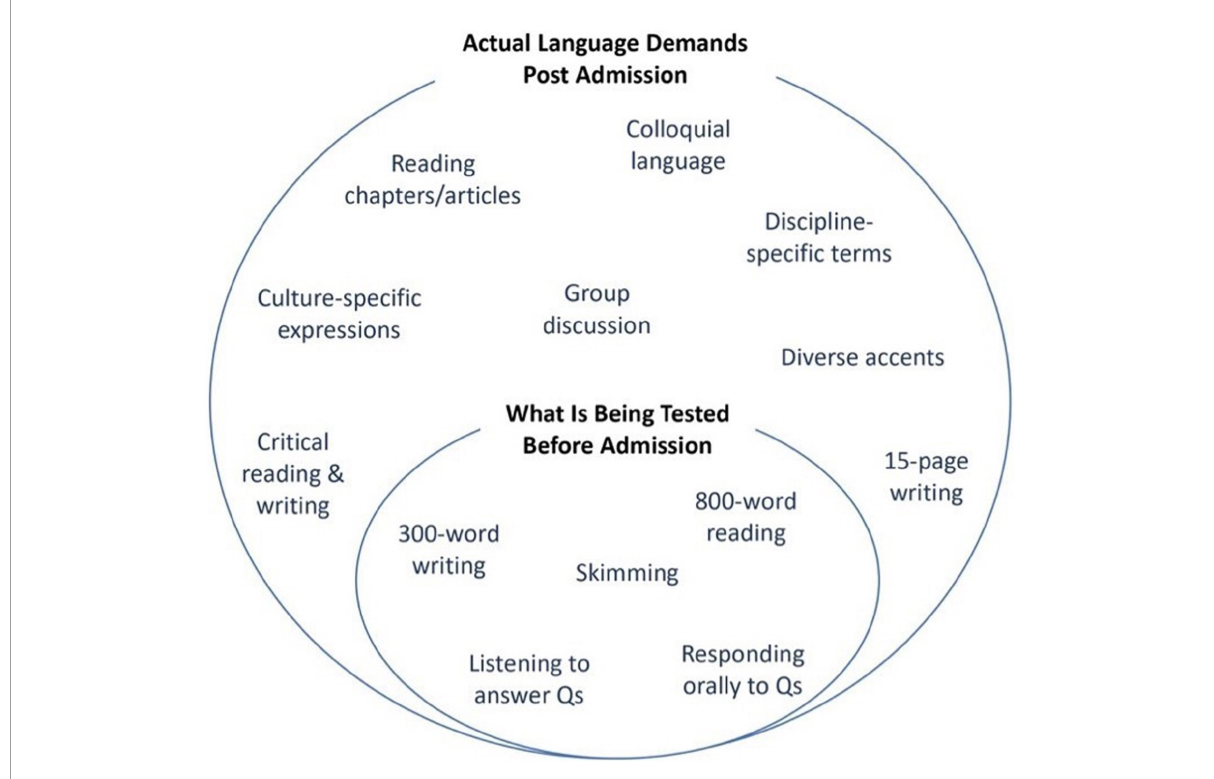
FIGURE2 University language demands and language